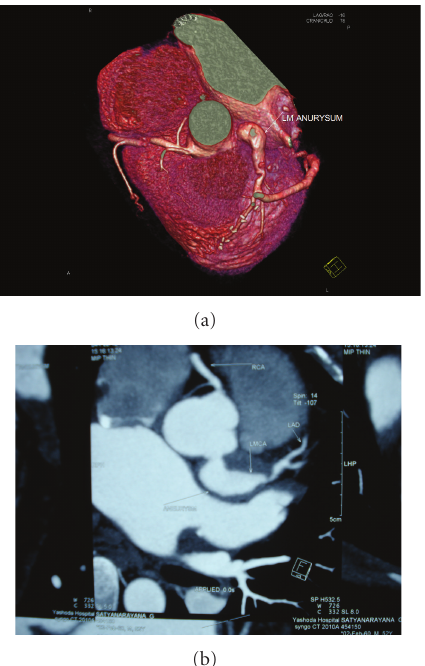
Figure 2: (a) CT Coronary angiogram showing left main aneurysm with ostial LAD stenosis. (b) CT Coronary angiogram showing left main aneurysm with ostial LAD stenosis.